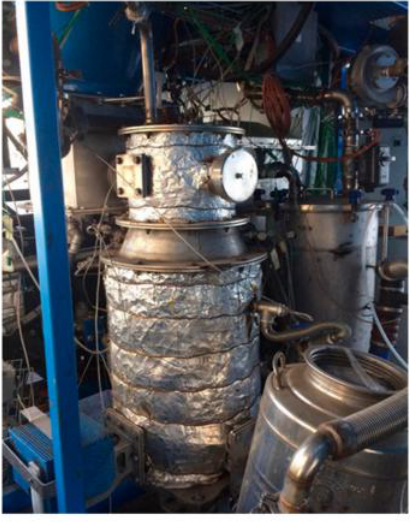
Figure 2. Downdraft gasifier developed by the C.M.D.